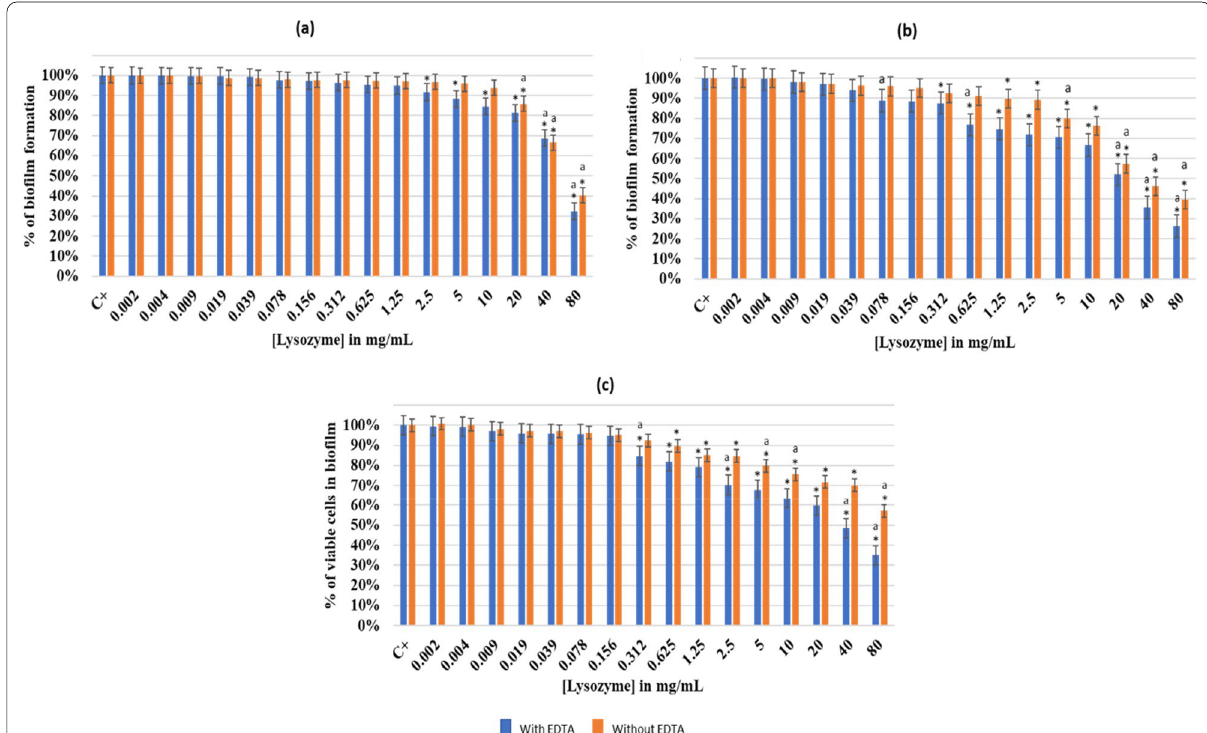
Fig. 7 Effect of Lysozyme with and without EDTA (1 mM) on different biofilms at pH7.5. a Lactobacillus rhamnosus GG, b Staphylococcus epidermidis 444, and c co-culture of both strains. The results are mean values of three replicates. (*) indicates a significant difference (P < 0.05) between each test and the positive control (without lysozyme). The lowercase letter a indicates a significant difference (P < 0.05) between each test and its preceding. Error bars represent the SD (standard